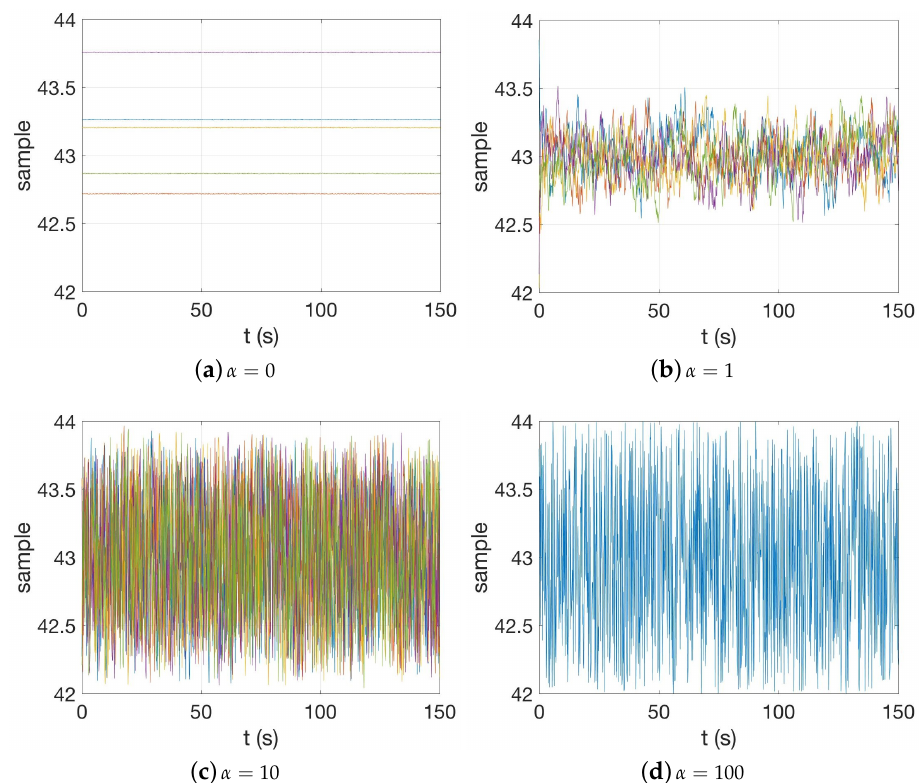
Figure 7. Samples with correlation function, r xx = e − ατ , at different values of α .